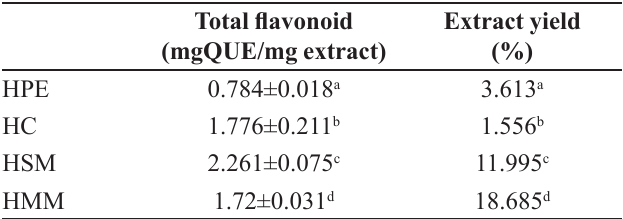
TABLE I - Extract yield percentage and total flavonoid contents of H. plicatum subsp.